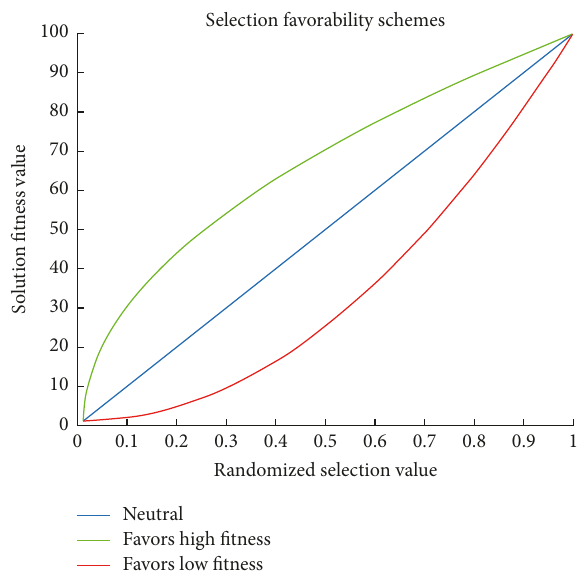
Figure 3: Three selection schemes for choosing parent chromo- somes. A randomized value in the range (0, 1) is chosen on the 𝑥 - axis and solution associated with the corresponding fitness value is used as a